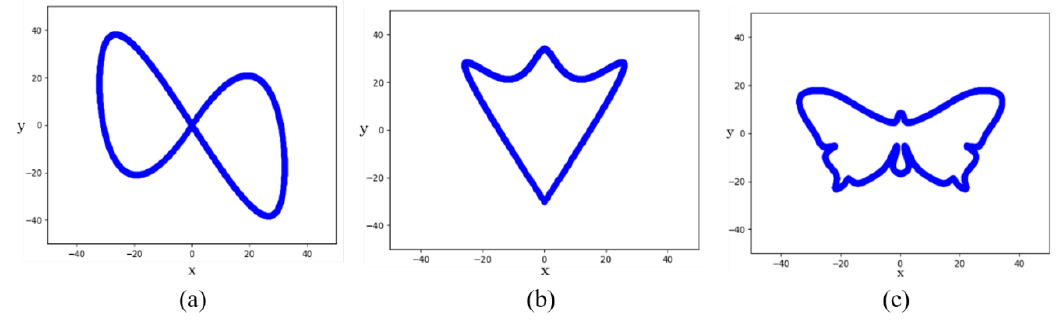
Figure 7. Experimental cutting graphs: ( a ) ∞ shape, ( b ) trident shape, and ( c ) butterfly shape.